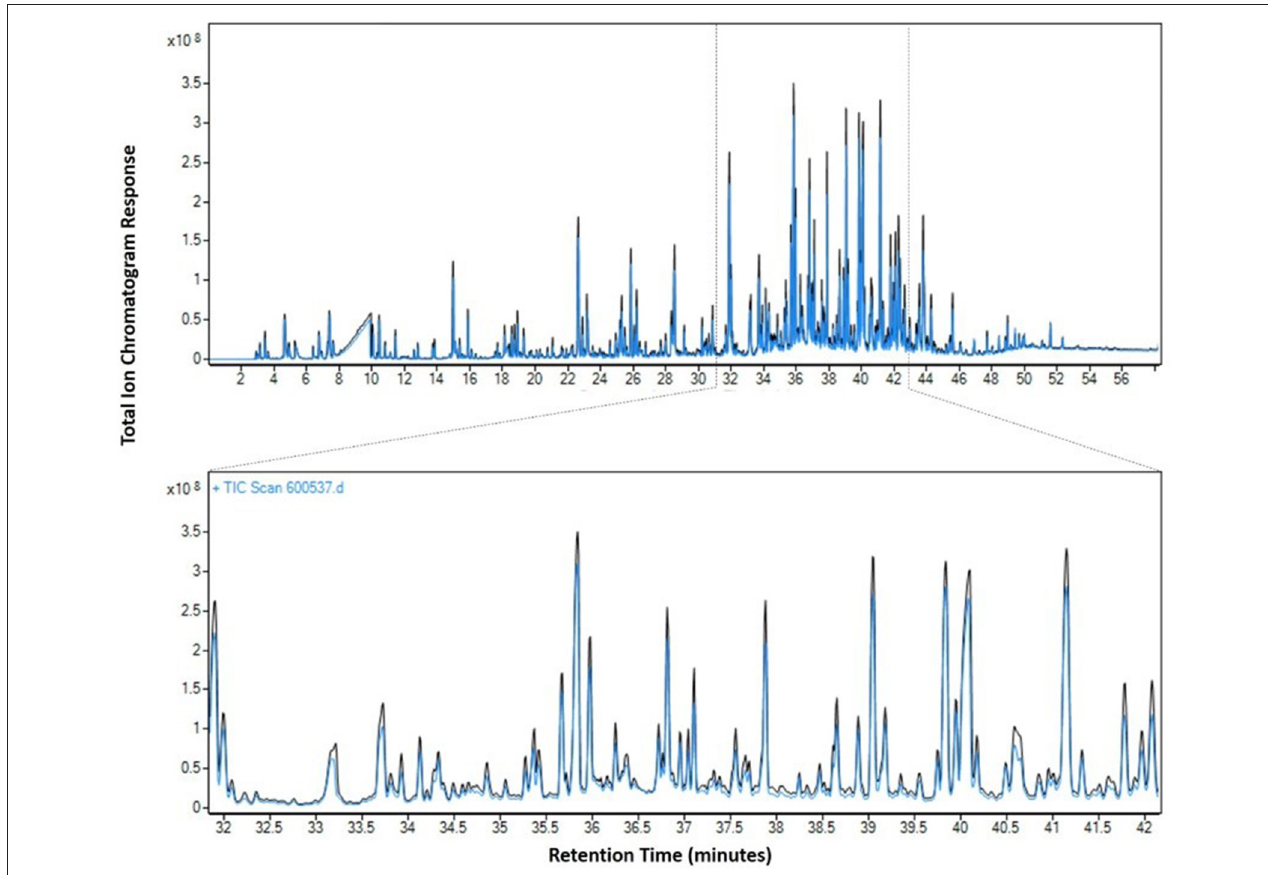
FIGURE 6 | Reproducibility of VEA emissions at 250 ◦ C. Blue line = emission test on 11/5/2019 and black line = emission test on 11/14/2019 with a zoomed region from 32 to